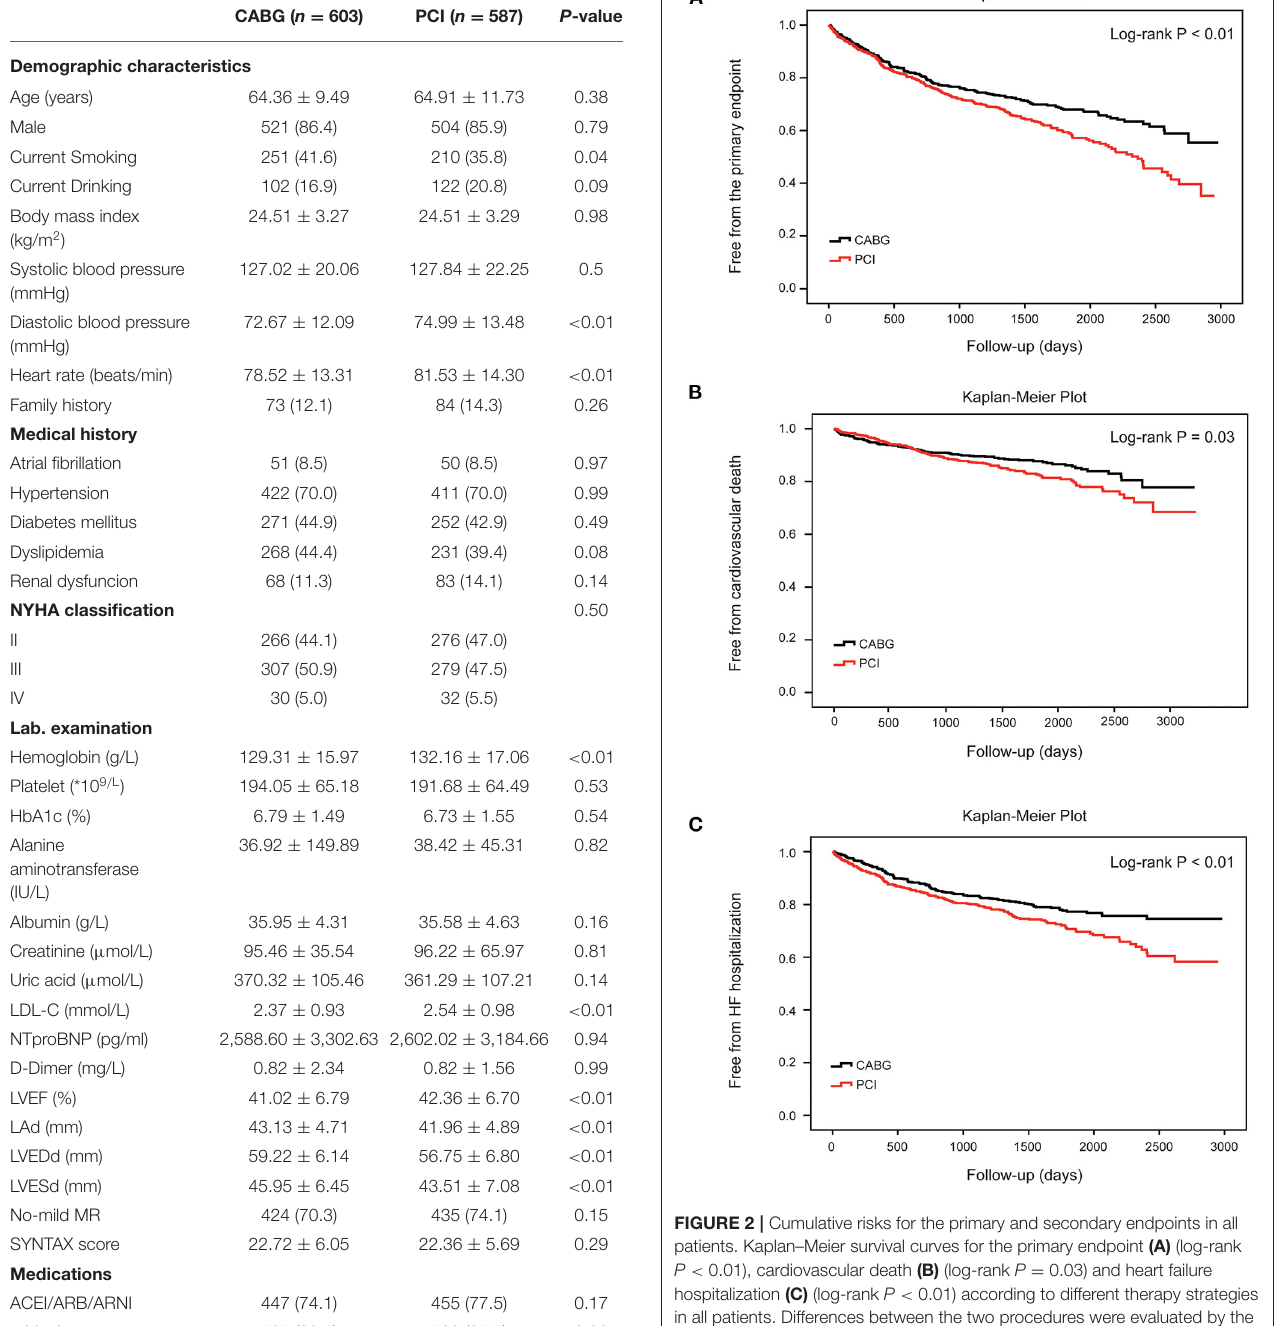
TABLE 1 | Baseline characteristics of study population by treatment strategies.